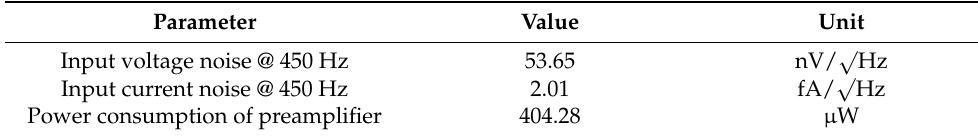
Table 20. Noise parameters of preamplifier op-amp.